Question: What caption would you write for this figure?
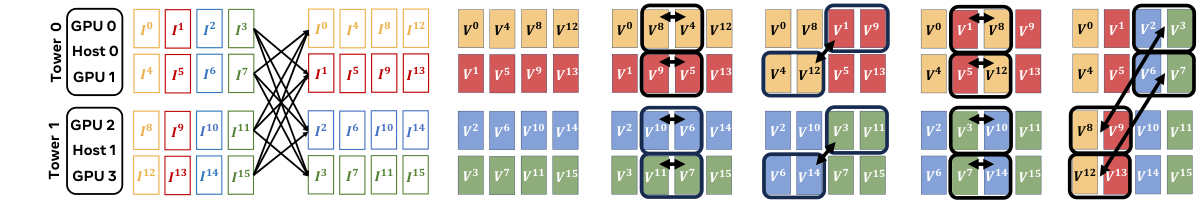
Answer: An operational view of the topology-aware embedding lookup process using semantic-preserving tower transform.